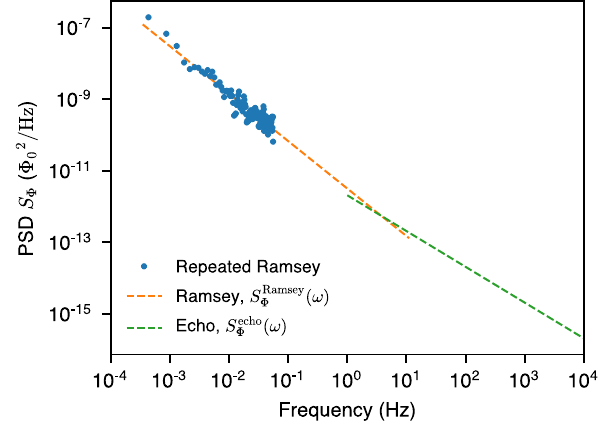
FIG. 12. The estimated flux noise PSD affecting QB2 from repeated Ramsey measurements (blue circles and the correspond- ing fit, orange dashed curve) and spin-echo experiments (green